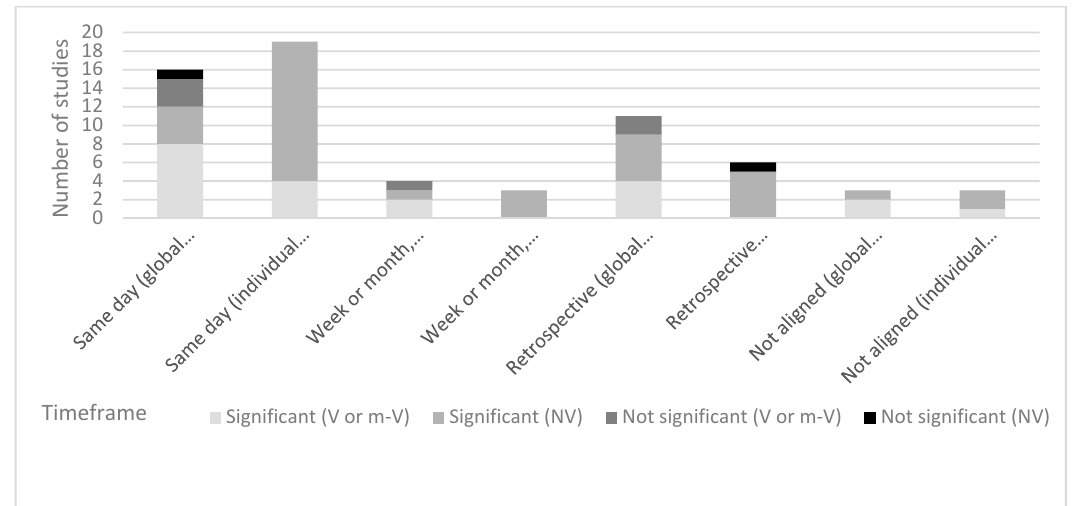
Figure 5. Significant and non-significant findings compared with the validation of symptom-reporting tools in studies assessing the influence of dietary intake on irritable bowel syndrome and functional dyspepsia symptoms.